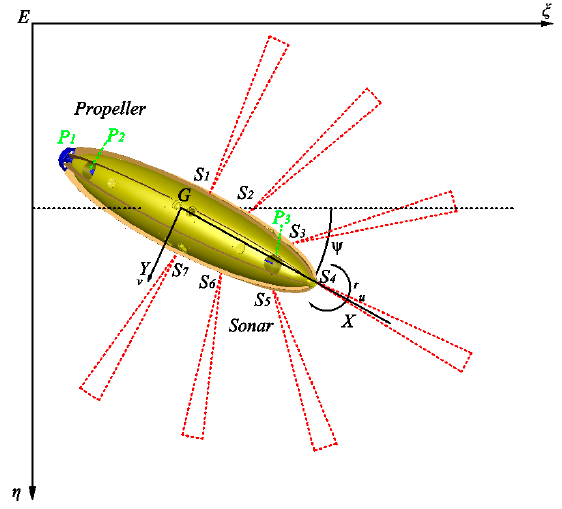
Figure 1. Major components of the autonomous underwater vehicles (AUV).